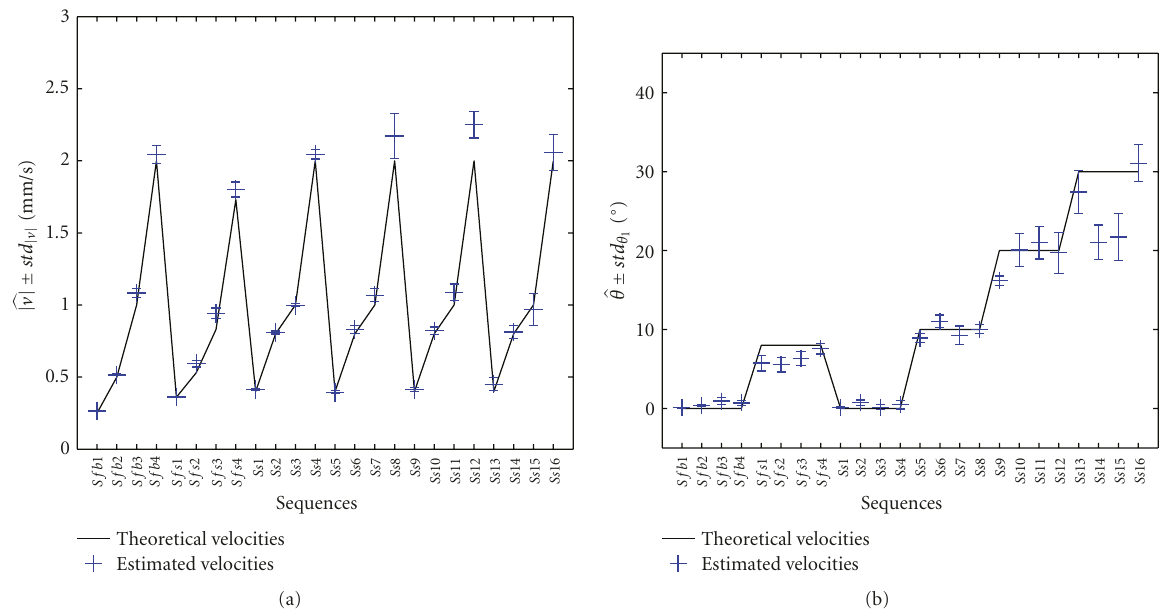
Figure 12: For each sequence, (a) mean and standard deviations of the mean velocity vector modulus (cid:13) | v | ± std | v | (b) mean and standard deviations of mean velocity vector orientation (cid:17) ϕ ± std ϕ